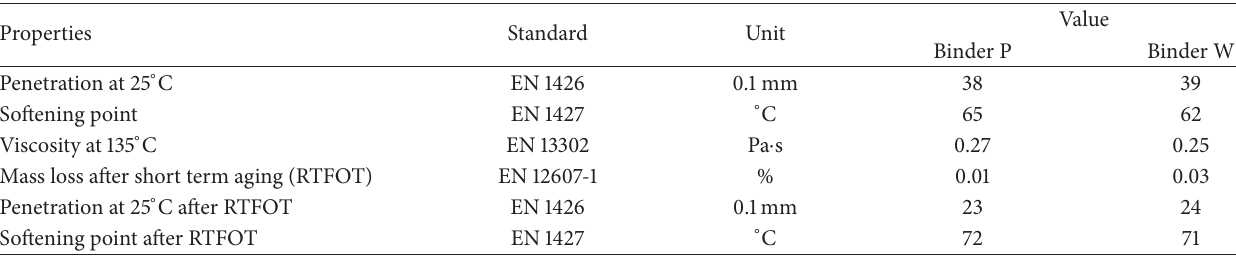
Table 1: Basic properties of the studied binders.